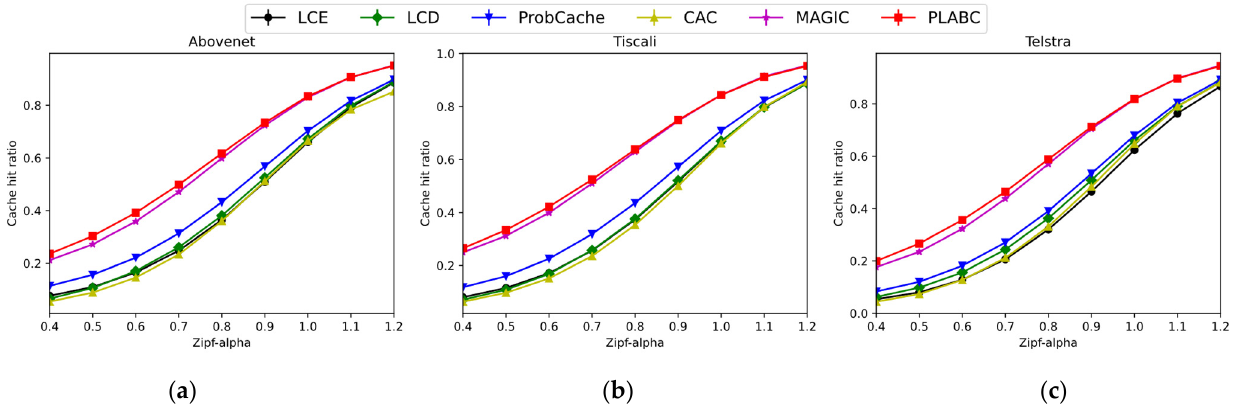
Figure 10. Cache hit ratio results of different caching strategies when Zipf exponent alpha varies under topology: ( a ) Abovenet; ( b ) Tiscali; ( c ) Telstra.